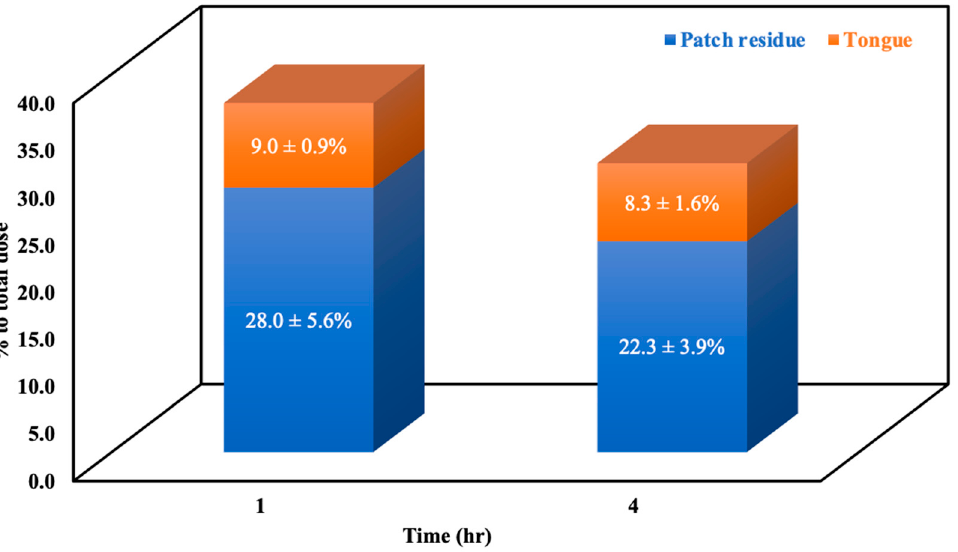
Figure 6. Patch residue and tongue tissue concentration percentage to total dosing of OXP by supralingual administration.